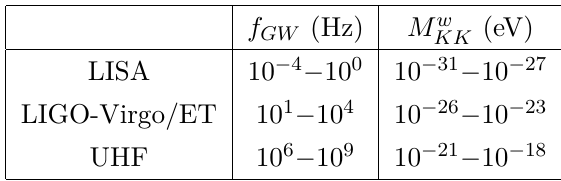
Table 4 . Frequency range of different gravitational wave experiments and the associated mass ranges for the case in which the wave corresponds to the excitation of a massive spin-2 mode of mass M w KK